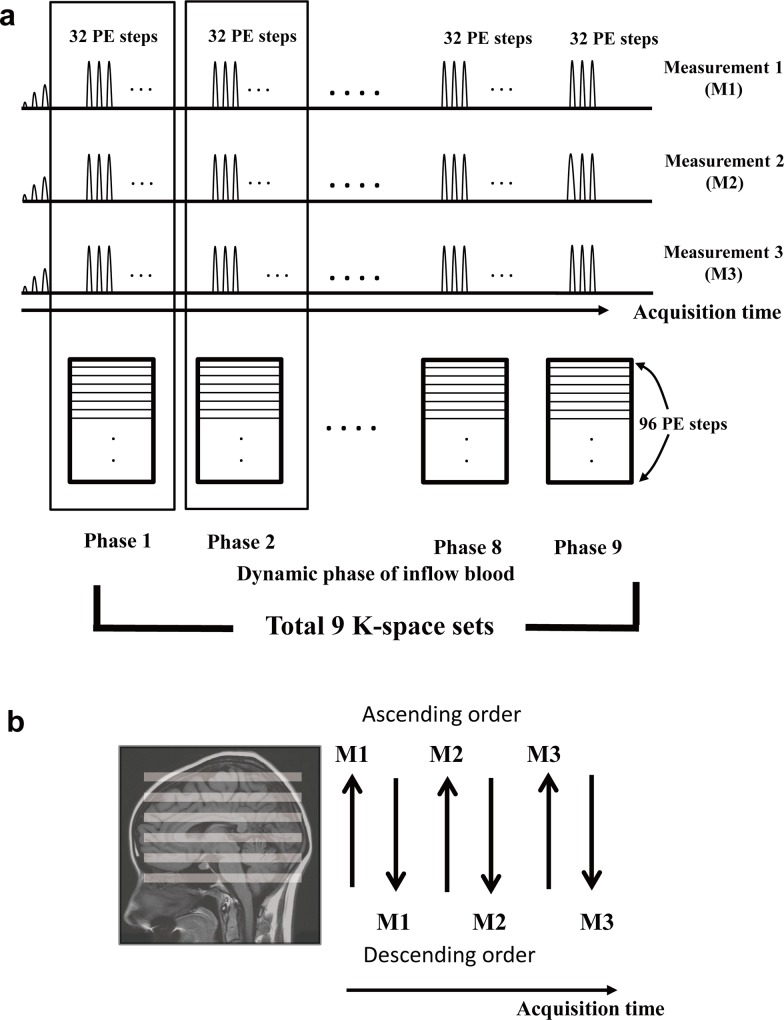
Diagram for segmented multiphase bSSFP sequence.(a) Initial 10 phase encoding scans with linearly increasing flip angles were discarded as dummy scans. Each measurement consisted of 288 phase encoding steps, which were subdivided into nine K-space datasets with 32 phase encoding lines per dataset. Since each K-space reflected different stage of flow dynamics, nine dynamic phases could be obtained. In order to fill 96 phase encoding lines per K-space, three measurements were performed. (b) ALADDIN acquisition scheme was composed of sequential ascending and descending orders, which were alternated in every measurement. Therefore, six measurements were needed to complete nine K-space datasets in both ascending and descending orders.